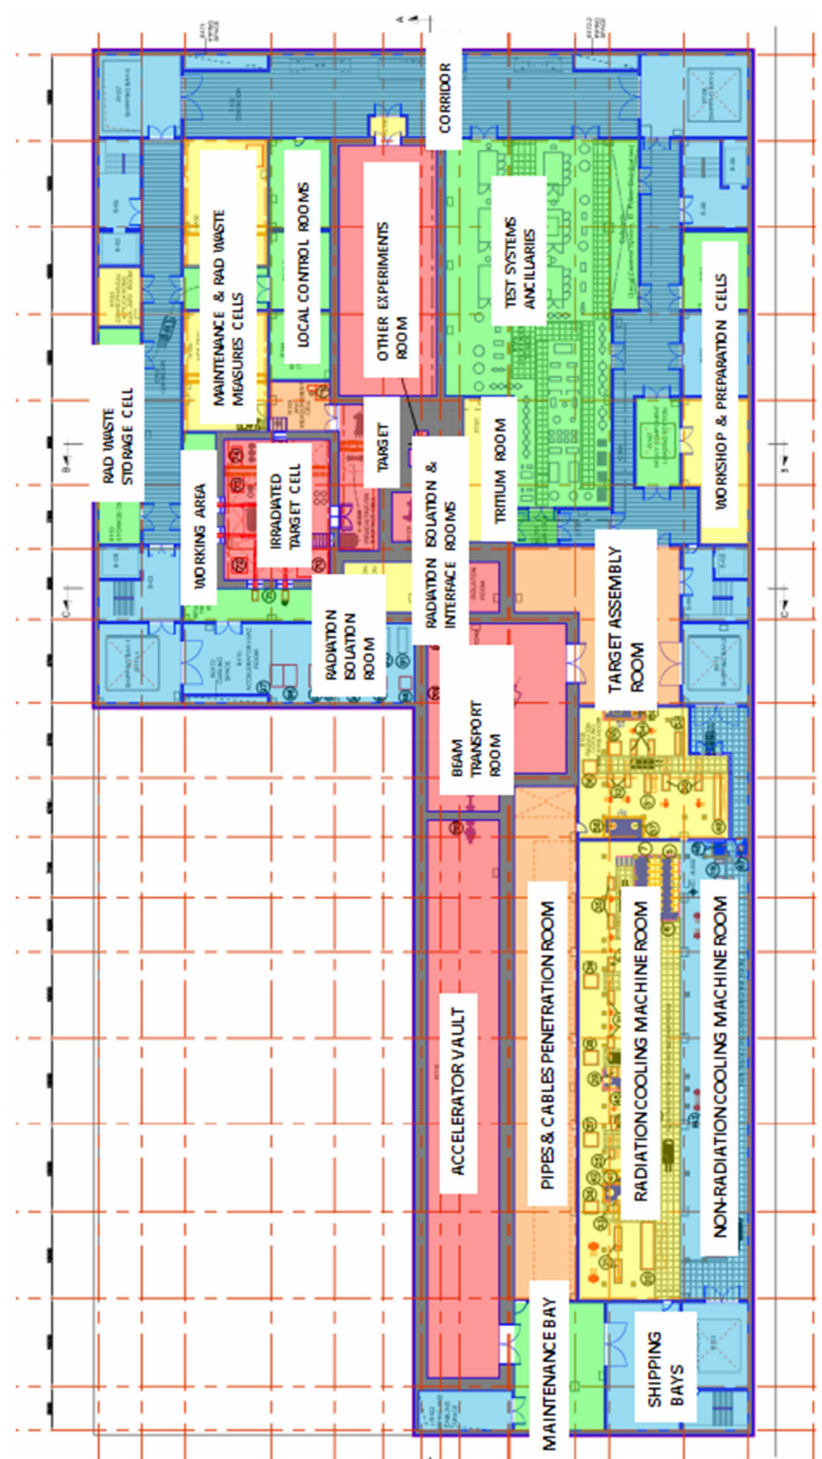
Figure 2. Radiation zones in the Main Building during operation at the accelerator plant level (Red color: prohibited access, > 100 mSv / h; orange: restricted / special access, < 100 mSv / h; yellow: restricted access, < 1 mSv / h; green: controlled area / frequent access, < 10 µ Sv / h; blue: supervised area / frequent access, < 3 µ Sv / h. Threshold values are based on Spanish Regulatory Guide GS-07.06 and Directive 2013 / 59 /